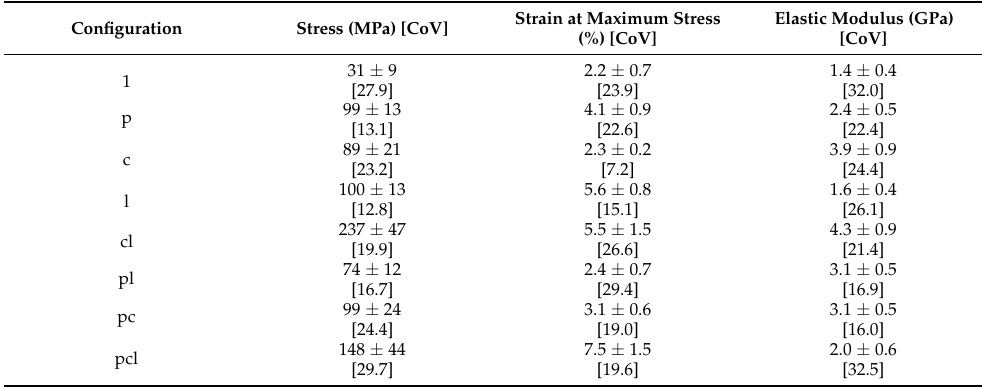
Table 7. Mechanical results obtained from testing. CoV represents the coefficient of